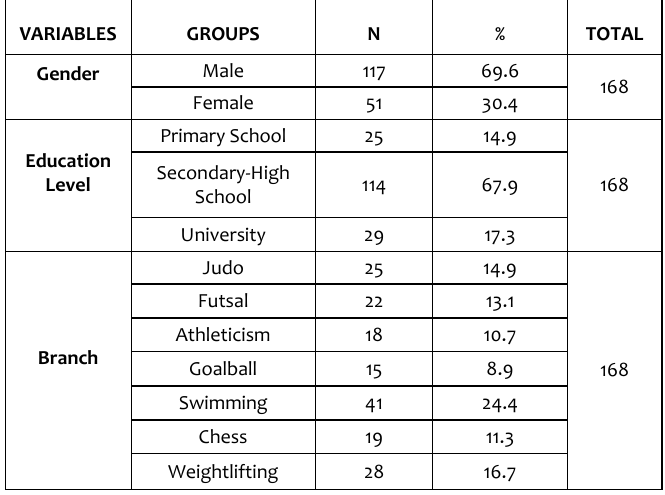
Table 1. Frequency Distribution with Respect to Demographic Characteristics of Visually Impaired Athletes who participated in the study